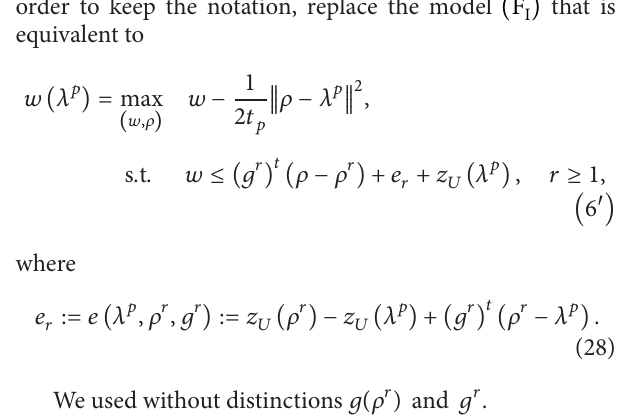
Algorithm 3. Initialization: They are given tolerance stop 𝛿